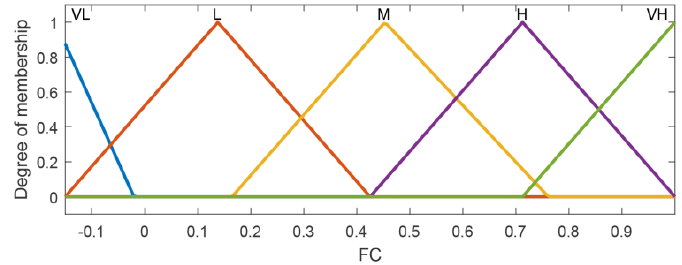
Figure 12. Output of FLEMS.